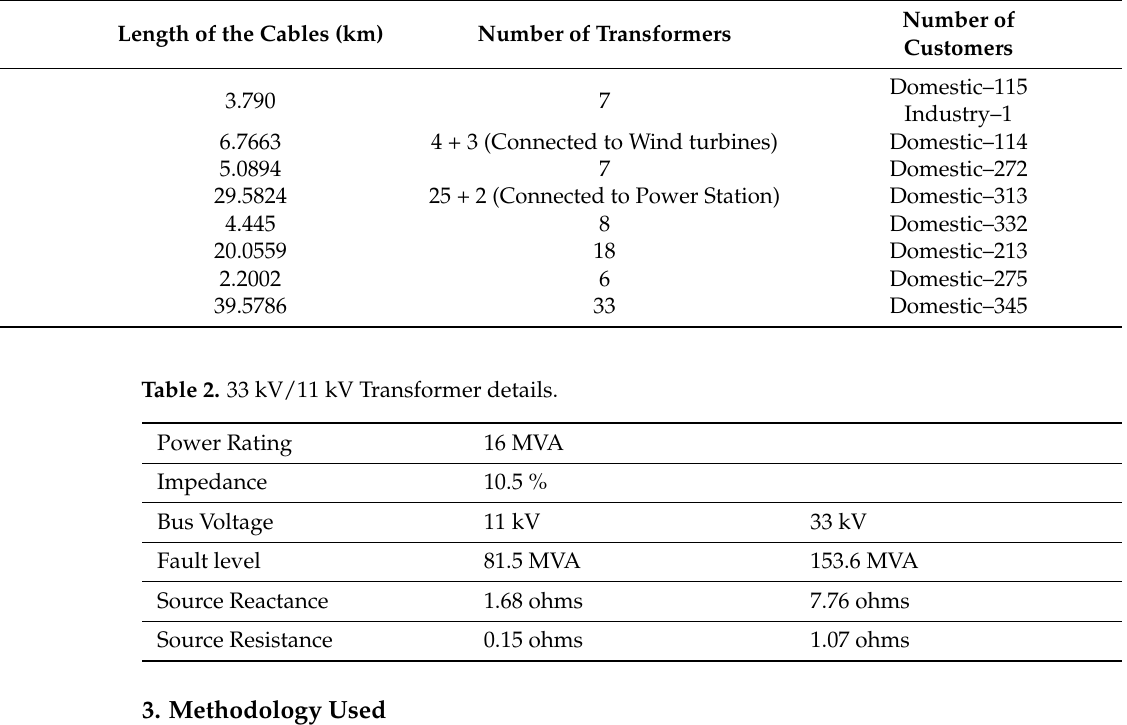
Table 1. Feeder details.